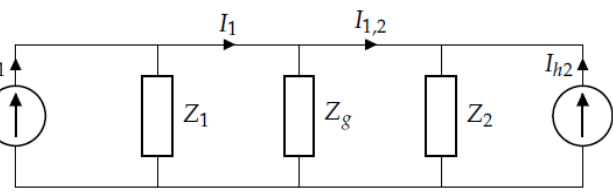
Figure 2. A simplified model, describing primary and secondary emissions in a system of two loads, assuming a sinusoidal rated